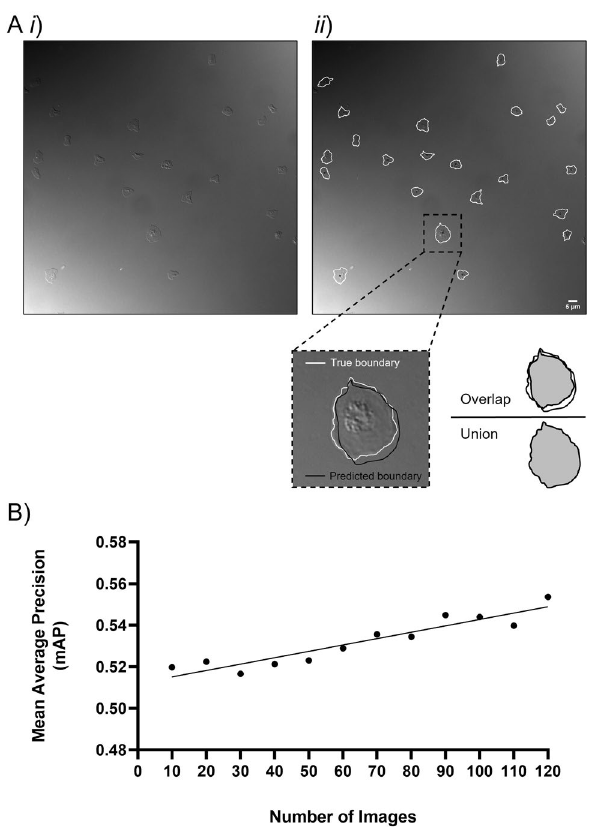
Figure 1. Increasing the number of images in the training set increases the performance of the CNN. Training consisted of a supervised approach to assist the training of the CNN. Representative DIC image ( Ai ). Representative manually annotated image ( Aii ). The true platelet boundary (white) as identified by manual annotations was compared to the predicted boundary (black) of the CNN ( Aii ). Comparing these boundaries evaluated the extent of overlap and returned mean average precision (mAP) whereby increasing increments of 10 images assessed the network performance up to 120 images ( B ). A linear regression model shows mAP increased with an increasing training set. Data represents the mean of three independently trained models.